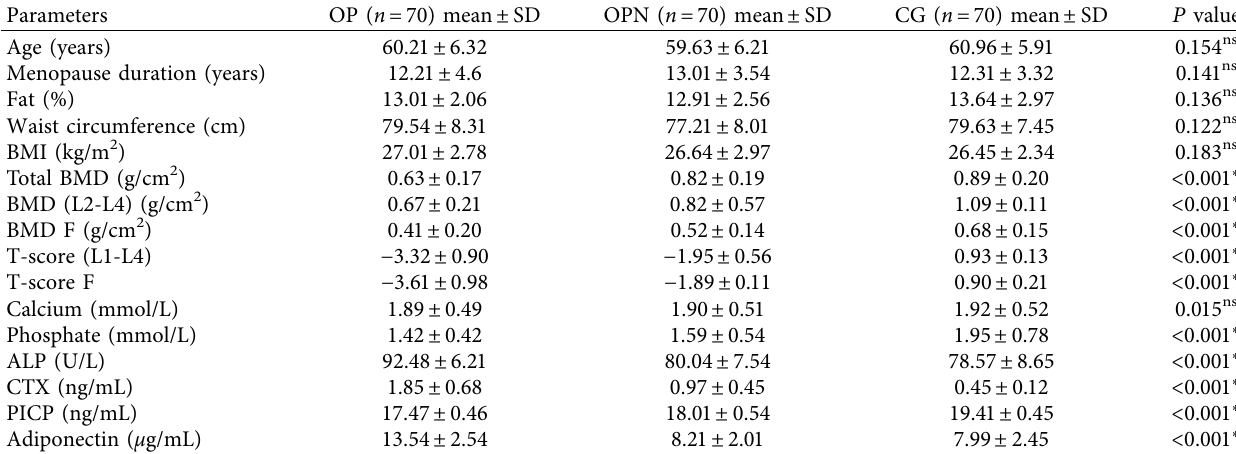
Table 1: Baseline parameters of the studied groups.